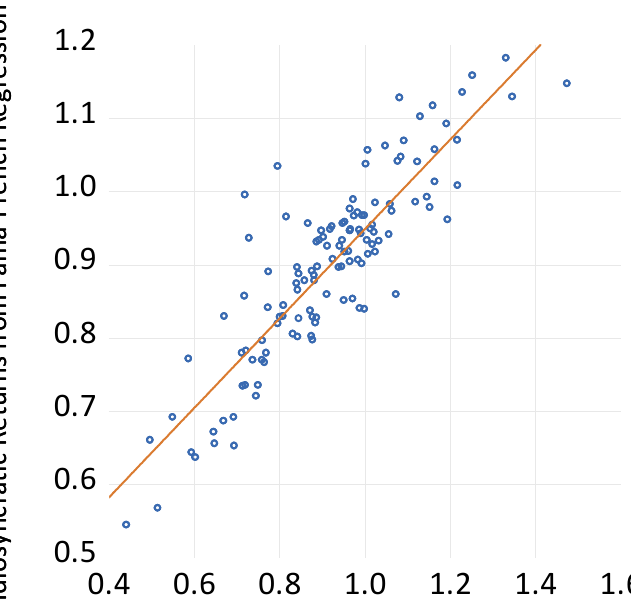
Figure 4. Values on 10 July 2020 of one dollar invested on 19 February 2020 not explained by eight macroeconomic factors versus corresponding values not explained by Fama and French factors. Note: The horizontal axis measures the values on 10 July 2020 across 125 sectors of a dollar invested on 19 February 2020 not explained by 8 macroeconomic factors. These factors are (1) the return on the aggregate U.S. stock market index, (2) the return on the world stock market index, (3) the change in the Federal Reserve broad trade-weighted exchange rate index, (4) the change in the log of the spot price from West Texas Intermediate crude oil, (5) the change in the breakeven inflation rate calculated from U.S. Treasury inflation-protected securities, (6) the change in the interest rate on three-month Treasury securities, (7) the change in the spread between interest rates on ten-year and three-month Treasury security, and (8) the change in the spread between interest rates on Moody’s seasoned Baa corporate bonds and ten-year Treasury securities. The vertical axis plots the corresponding values not explained by the five Fama and French (2015) factors. These factors are (1) the return on the aggregate U.S. stock market index minus the return on one-month Treasury securities, (2) the average return on nine small capitalization stock portfolios minus the average return on the nine large capitalization stock portfolios, (3) the average return on two high-book value to market value portfolios minus the average return on the two low-book value to market value portfolios, (4) the average return on two robust operating profitability portfolios minus the average return on two weak operating profitability portfolios, and (5) the average return on two conservative investment portfolios minus the average return on two aggressive investment portfolios. Changes in value not explained by macroeconomic factors over the 19 February–10 July 2020 period include sector-specific responses to the COVID-19 pandemic. Source: Datastream database, Federal Reserve Bank of St. Louis FRED database, homepage of Professor Kenneth French, and calculations by the author.